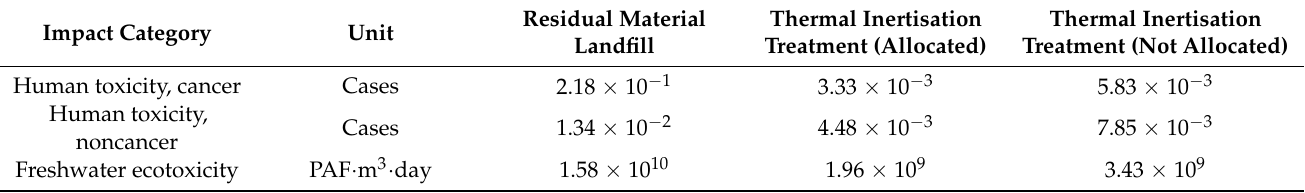
Table 1. Life-cycle inventory assessment (LCIA) comparison for the two ACMs scenarios for 150 ton of ACW